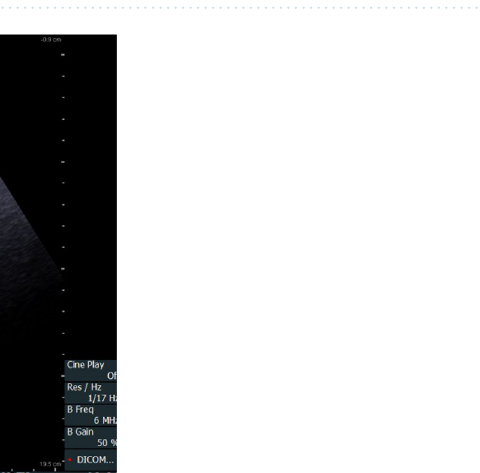
Figure 1. ( a ) Preoperative membranous urethra length—MULpre = 21 mm, measured in transperineal ultrasound—TPUS. ( b ) Preoperative membranous urethra length—MULpre = 22.5 mm, measured in transrectal ultrasound—TRUS.